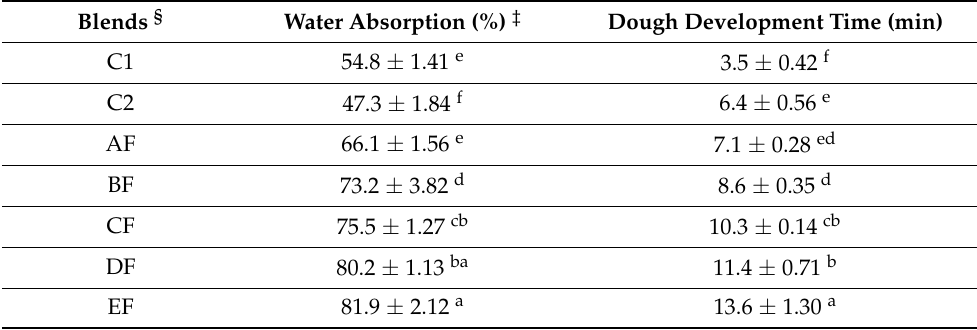
Table 3. Farinogram data for the flour